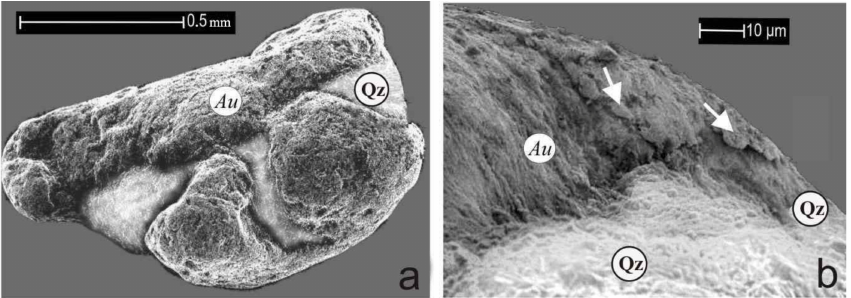
Figure 14. Gold-encrusted well-rounded quartz found in one of the placer occurrences of the Lena– Anabar interfluve: ( a ) general view; ( b ) detail, the film-fibrous surface of gold, characteristic of aeolian transformations (shown by arrows); Au = native gold, Qz =